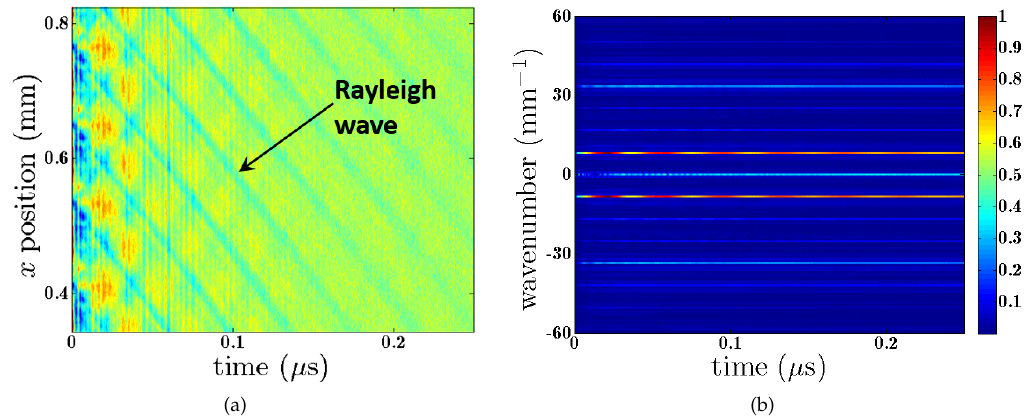
Figure 7. ( a ) Normalized ( x , t ) -dependence of the high-pass filtered laser beam deflection signal at the coating surface of the GESA modified sample, excited by a transient grating with a fringe of 120 µ m. The diffraction grating was scanned (d x = 0.5 µ m) in the direction of wave propagation. To guide the eye, Rayleigh waves with a wavelength of 120 µ m are indicated. ( b ) Normalized ( k , t ) -signal of the logarithmically scaled signal obtained after performing a one-dimensional Fourier transform along the x -direction of the signal in ( a ). By virtue of the non-sinusoidal glass etch relief of the diffraction grating, multiple wavenumber components were excited, emerging as relative bright horizontal lines in the Figure.